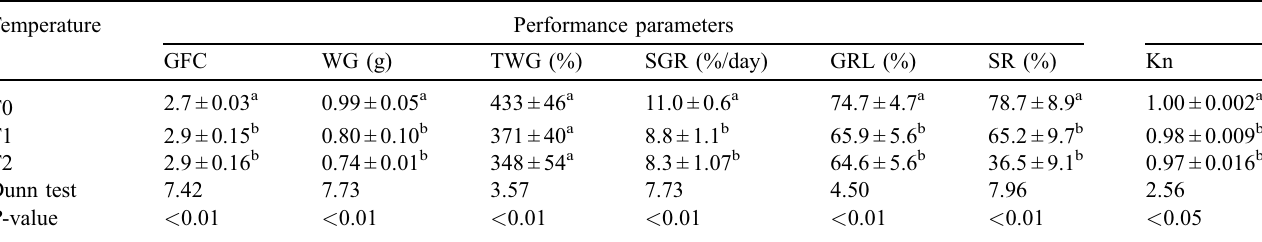
Table 2. Performance parameters of Macrobrachium amazonicum juveniles after 90 days of cultivation at different temperature treatments (T0: 28 ±0.5 ° C, T1: 30 ±0.2 ° C, T2: 32± 0.5 ° C).